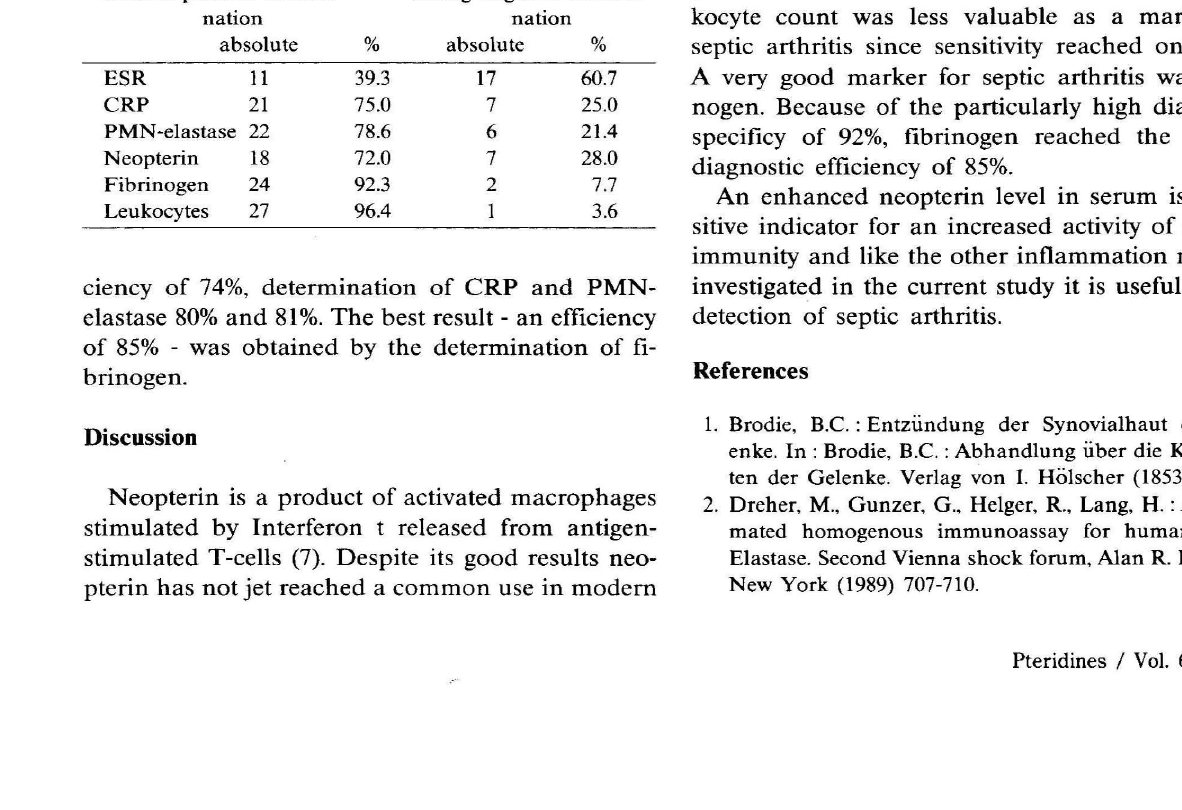
Table 4. Evaluation of inflammation markers in the refer- ence group